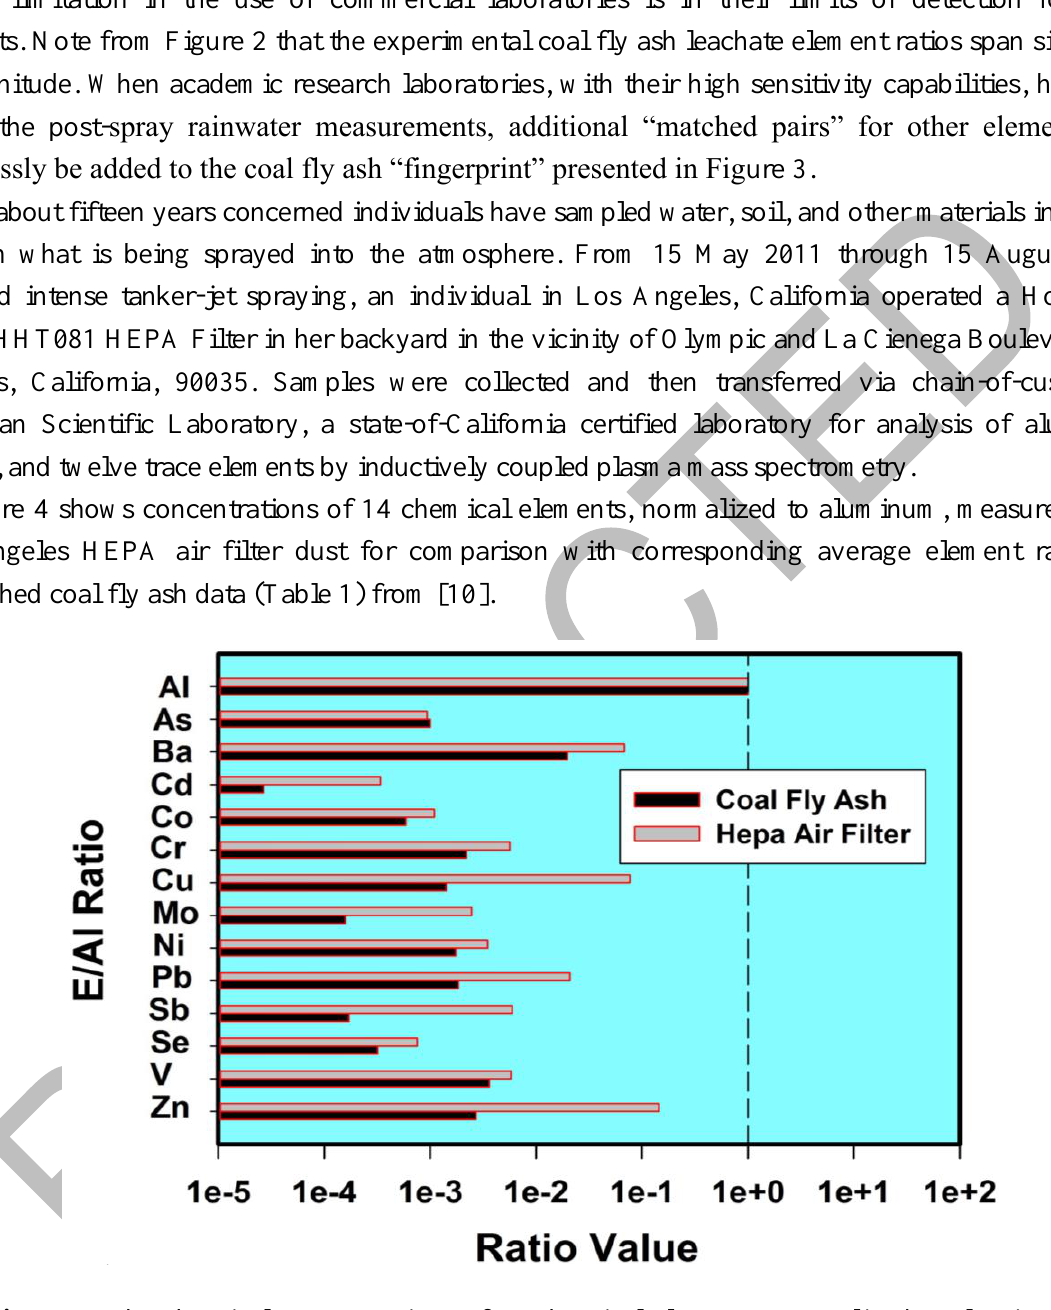
Figure 4. The chemical concentrations of 14 chemical elements, normalized to aluminum, measured in the Los Angeles HEPA air filter dust for comparison with corresponding average element ratios for un-leached coal fly ash (Table 1) data from [10]. This figure shows the 14 elements measured in the collected filter dust occur in the same relative proportions as similar elements in un-leached coal fly ash from published laboratory investigations [10]. This is strong evidence that the substance emplaced into the troposphere is coal fly ash. At a 99% confidence interval, the two sets of data have the same mean (T-test) and the same variance